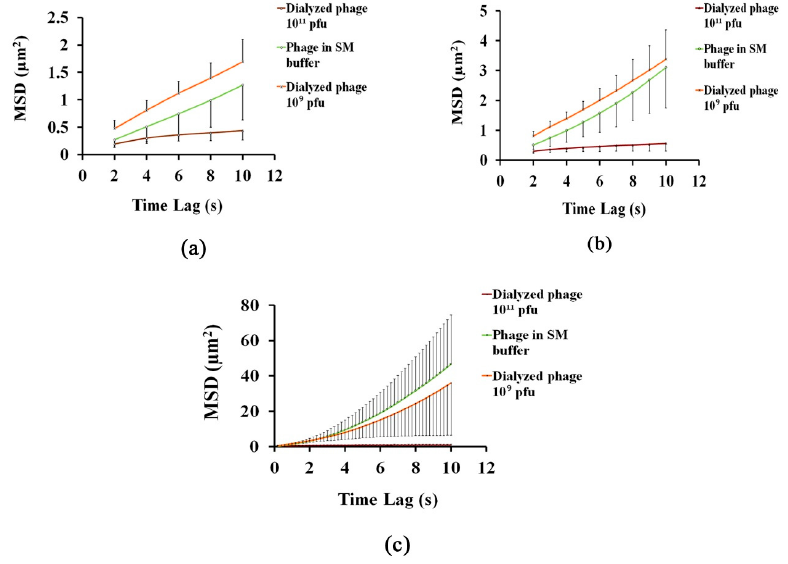
Figure 4. Mean square displacement of phage nanoparticles under different conditions with ( a ) τ = 5; ( b ) τ = 10; and ( c ) τ = 50. ( b ) τ = 10; and ( c ) τ =